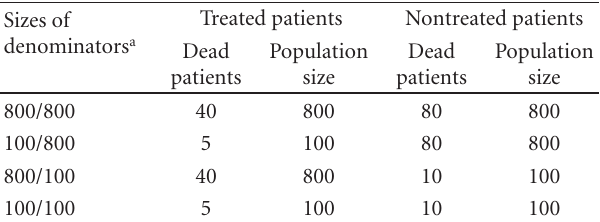
Table 1: Number of treated and nontreated patients who died from a heart attack used in fictitious medical